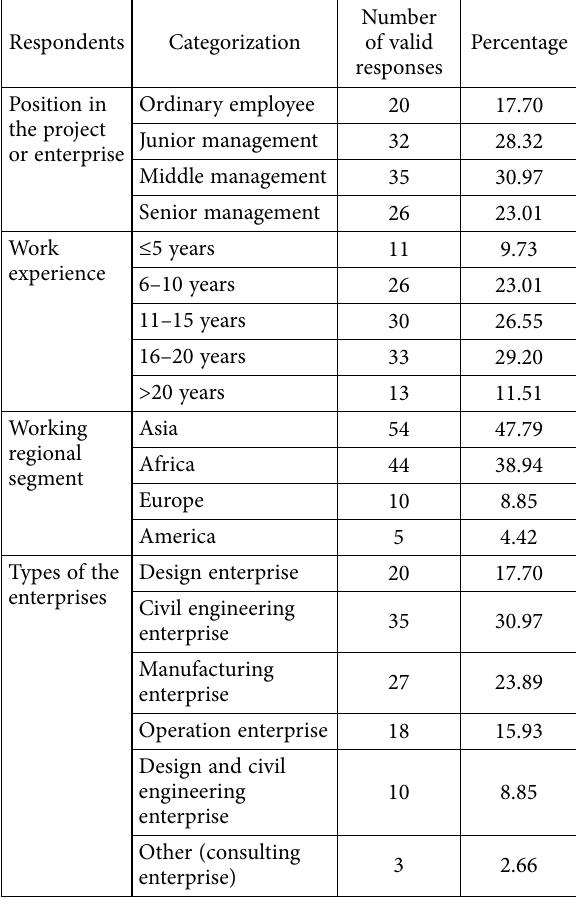
Table 2. General information of the respondents